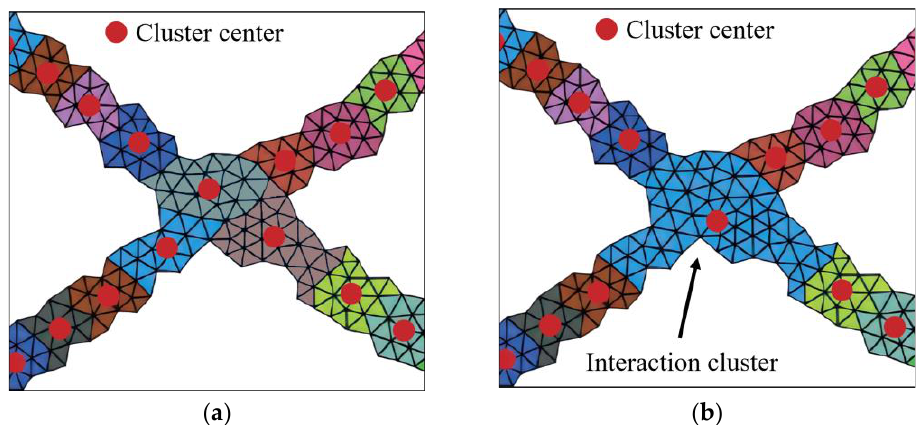
Figure 3. Schematic diagram of shock clusters: ( a ) the initial result of the shock clusters, ( b ) the final result of the shock clusters.